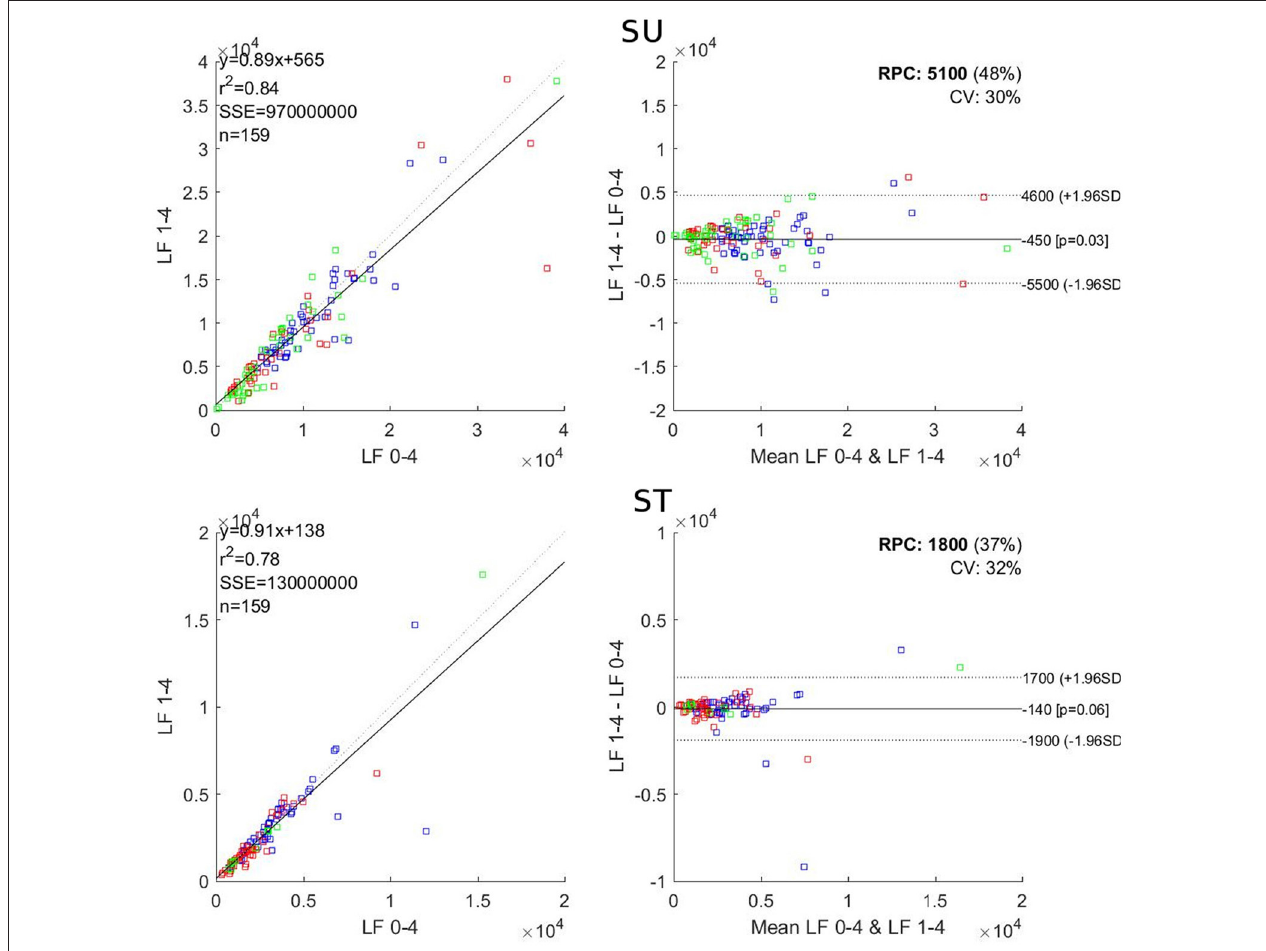
FIGURE 1 | Correlation (Left) and Bland and Altman (Right) plots for comparison of LF in the 1–4 and the reference 0–4 windows. SU, supine; ST, standing; r 2 , Pearson r square; SSE, sum of square error; RPC, reproducibility coefficient; CV, coefficient of variation. Blue dots: Subject 1; red dots Subject 2; green dots: Subject